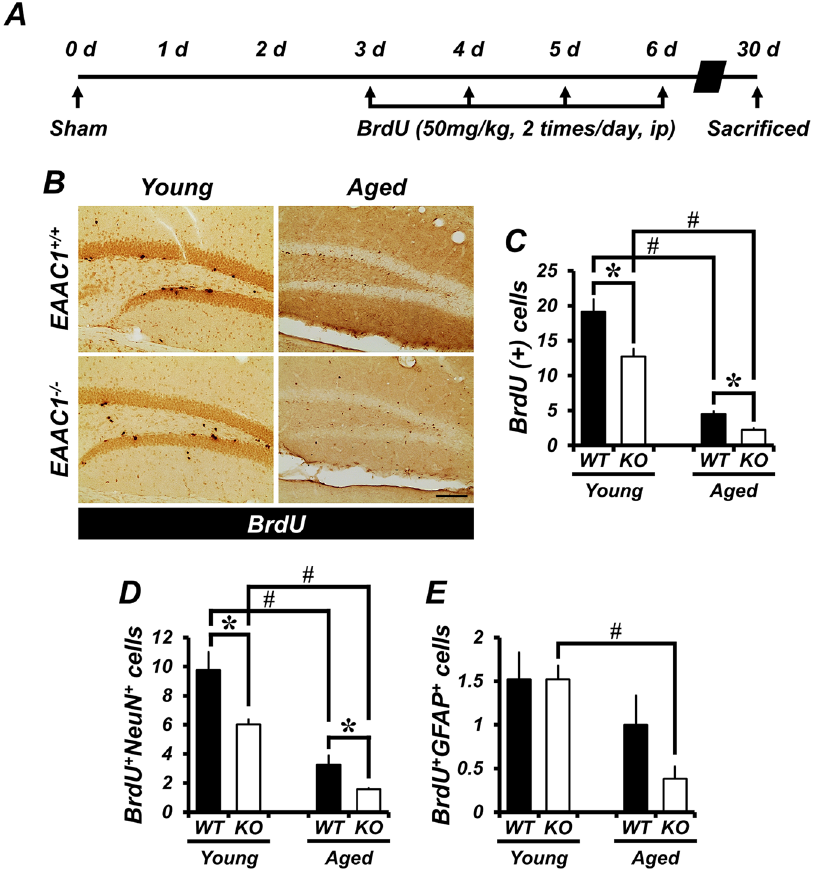
Figure 5. Genetic deletion of EAAC1 reduces survival of newborn neurons. ( A ) The schematic diagram shows the experimental procedure used in this study. BrdU was intraperitoneally injected twice per day for 4 consecutive days from day 3 after sham surgery. Mice were killed on day 30. ( B ) Photomicrographs show the distribution of BrdU-labeled cells in the SGZ/GCL of the hippocampus of young and aged mice (WT or EAAC1 − / − ). Newborn cells were labeled with BrdU, and their survival was assessed 30 days after sham surgery. Scale bar = 100 μ m. ( C ) Graph shows the number of BrdU-labeled cells in the SGZ/GCL from young or aged mice (either WT or EAAC1 − / − ) at 30 days after sham surgery. Data are expressed as the mean + SEM; n = 6–9 from each group, * p < 0.05 versus WT mice; # p < 0.05 versus young mice. ( D , E ) The bar graph represents the number of BrdU-labeled cells that were colocalized with NeuN ( D ), or GFAP ( E ) in the SGZ/GCL of young and aged mice (WT or EAAC1 − / − ) at 30 days after sham surgery. Data are represented as the mean + SEM; n = 5–8 from each group, * p < 0.05 versus WT mice; # p < 0.05 versus young